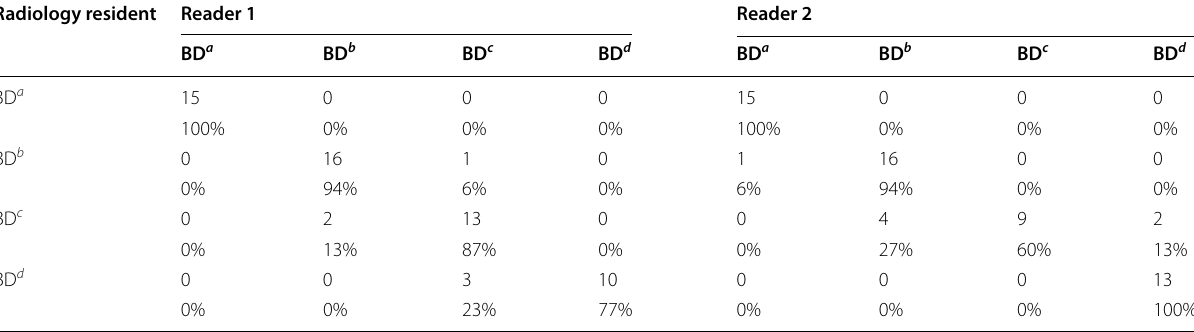
Table 6 Mean values and coefficients of variance for 19 texture features for the subset of 60 images